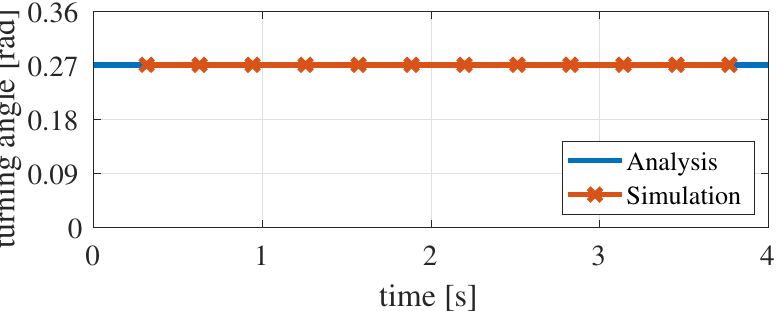
Figure 12. The time variation of the turning angle in the simulation for the counter-clockwise turning locomotion. Since the turning angle indicates 0.27 rad, the simulation results show that the robot turns to the left by setting β = π /6.